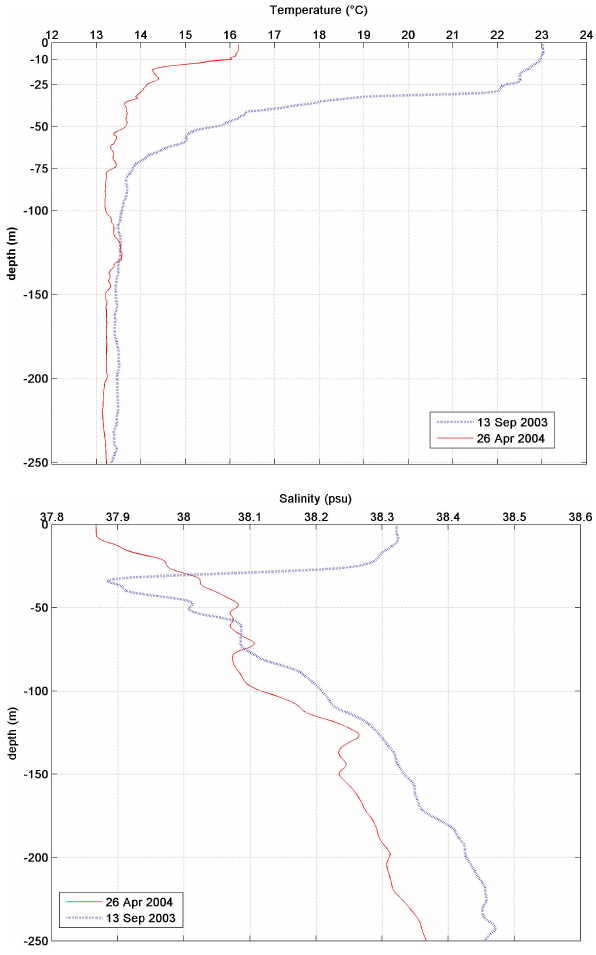
Fig. 2. Temperature (a) and Salinity (b) profiles taken on 13th of September 2003 and 26th of April 2004 close to the ODAS Buoy.